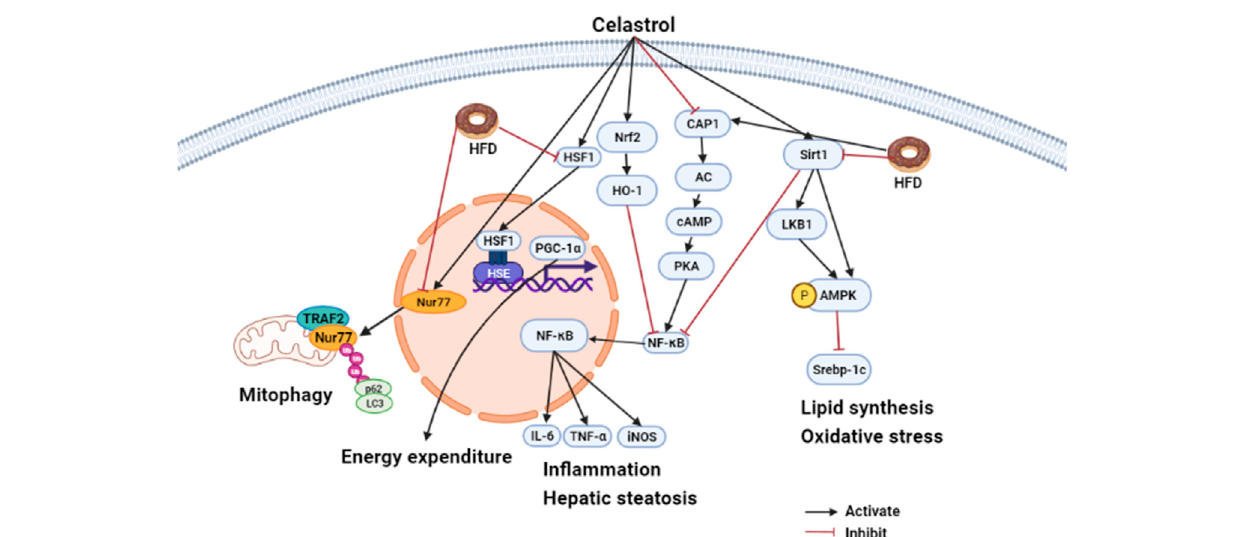
FIGURE 2 | Hepatoprotective effects of celastrol in HFD induced animal model (edited by Biorender software). Diagram of the mechanism of celastrol in regulating hepatic energy expenditure, in fl ammation, and lipid metabolism. Under HFD stress, celastrol attenuated in fl ammation by inducing Nur77 interaction with TRAF2 to promote mitochondrial autophagy. Macrophages mediated in fl ammation was also ameliorated by celastrol targeted CAP1 via inhibition of cAMP-PKA-NF- κ B signaling pathway, and macrophage M1 polarization was suppressed by celastrol via regulating Nrf2-HO-1-NF- κ B pathways. In addition, celastrol can also regulate metabolism disorder. On the one hand, it can promote energy metabolism by activating HSF1-PGC1 α ; on the other hand, it can target SIRT1 to promote AMPK α phosphorylation and inhibit Srebp-1c-mediated lipid synthesis against oxidative stress and in fl ammation TRAF2, TNFR-associated factor2; CAP1, adenylyl cyclase- associated; protein 1 cAMP, cyclic adenylate monophosphate; PKA, protein kinase A; NF- κ B, nuclear factor kappa-B; Srebp-1c, sterol regulatory element binding protein 1c; AMPK α , AMP-activated protein kinase α .